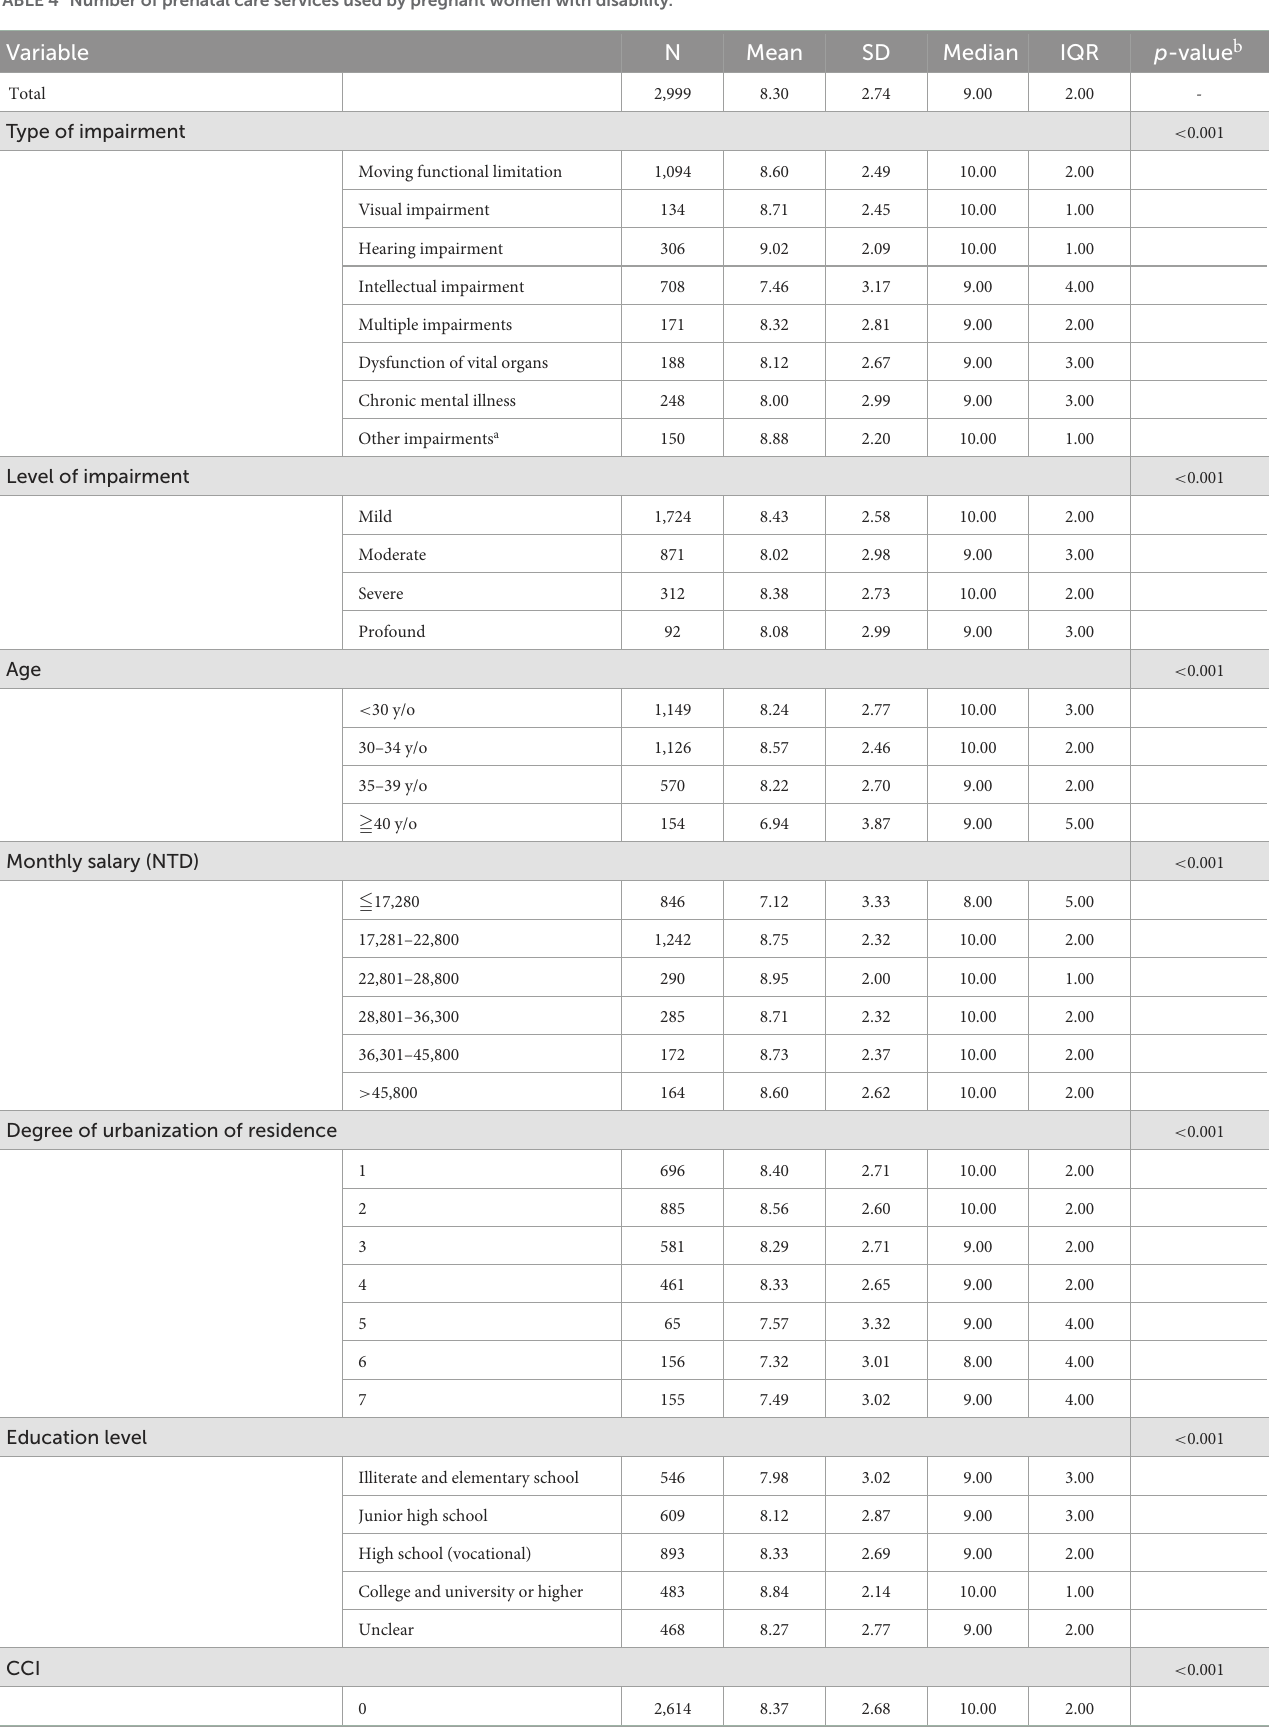
TABLE 4 Number of prenatal care services used by pregnant women with disability. Variable N